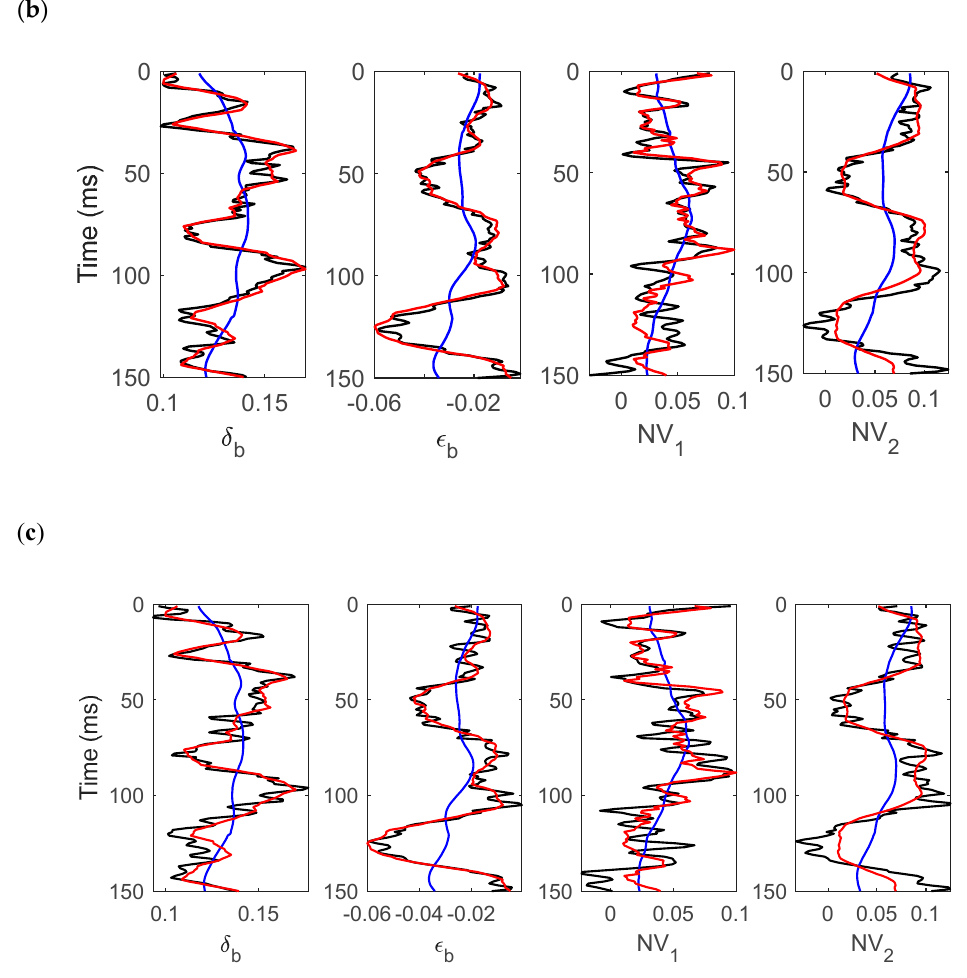
Figure 5. Comparisons between the estimated results (black curves) and the true values (red curves). The blue curves represent initial models that were constructed by smoothing the true values. ( a ) noise-free, ( b ) S / N of 5, ( c ) S / N of 2.